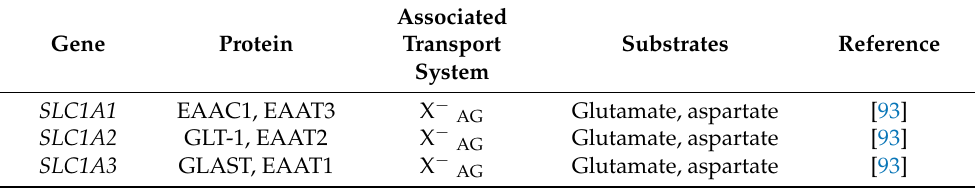
Table 2. Amino acid transporters identified in bovine mammary